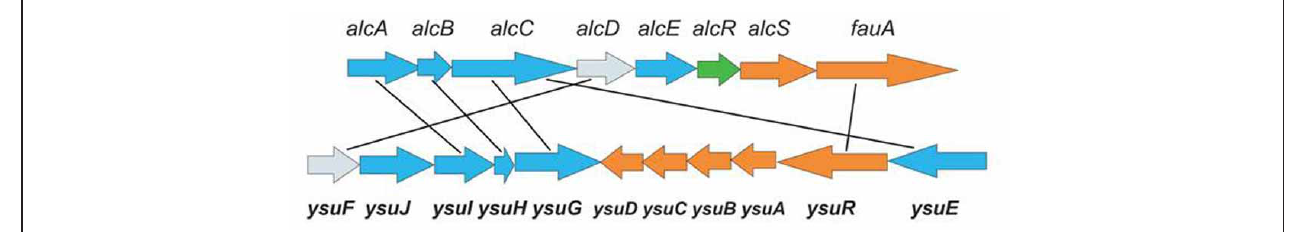
FIGURE 3 | Comparison of the alc -cluster encoding the production of the alcaligin siderophore in Bordetella spp with the ysu -cluster encoding the production of the yersiniachelin siderophore in Y. pestis .